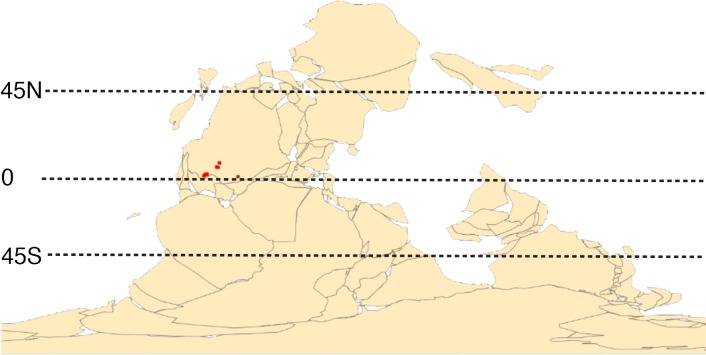
Occurrence points of Metacoceras sp. and Mooreoceras sp.For the Virgilian, shown on possible paleogeography of that stage, at 1:1,000,000,000 scale; plotted using PaleoWeb (Rothwell Group LP, 2016).